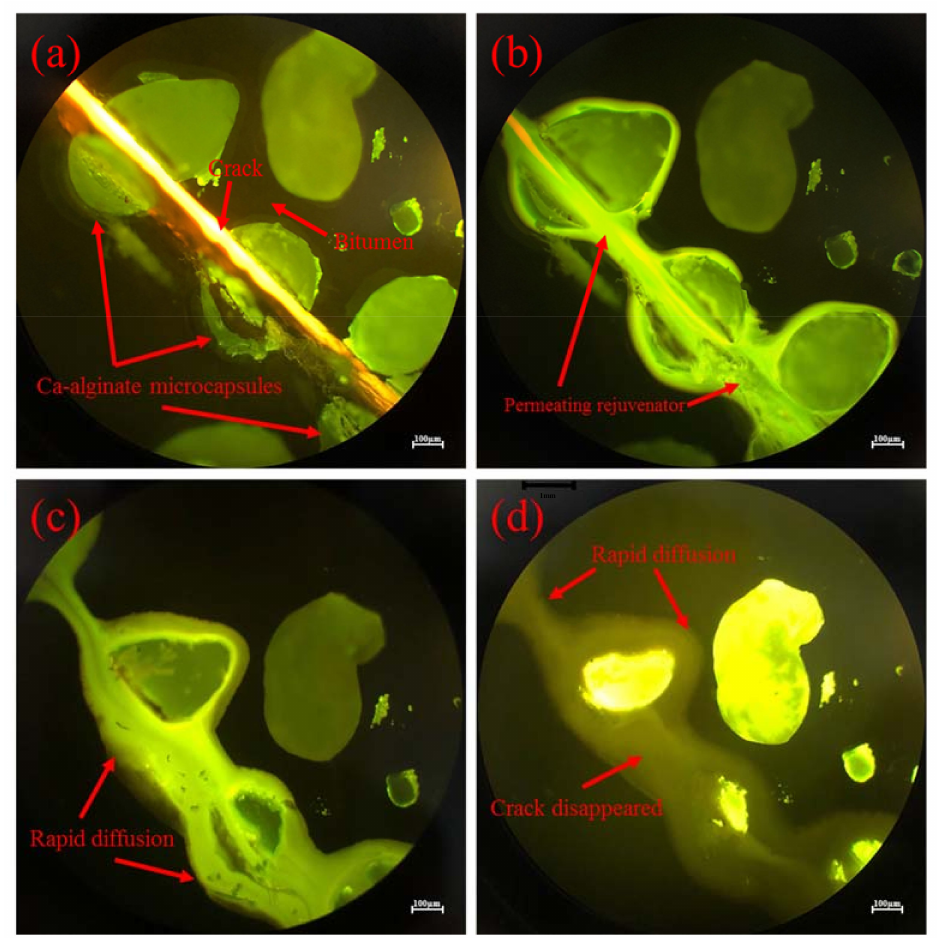
Figure 9. Micro self-healing process of bituminous binder with Ca-alginate microcapsules characterized by fluorescence microscope and optical microscope test (at 20 ◦ C): ( a ) once a crack was produced; ( b ) after 30 s; ( c ) after 1 min; ( d ) after 4